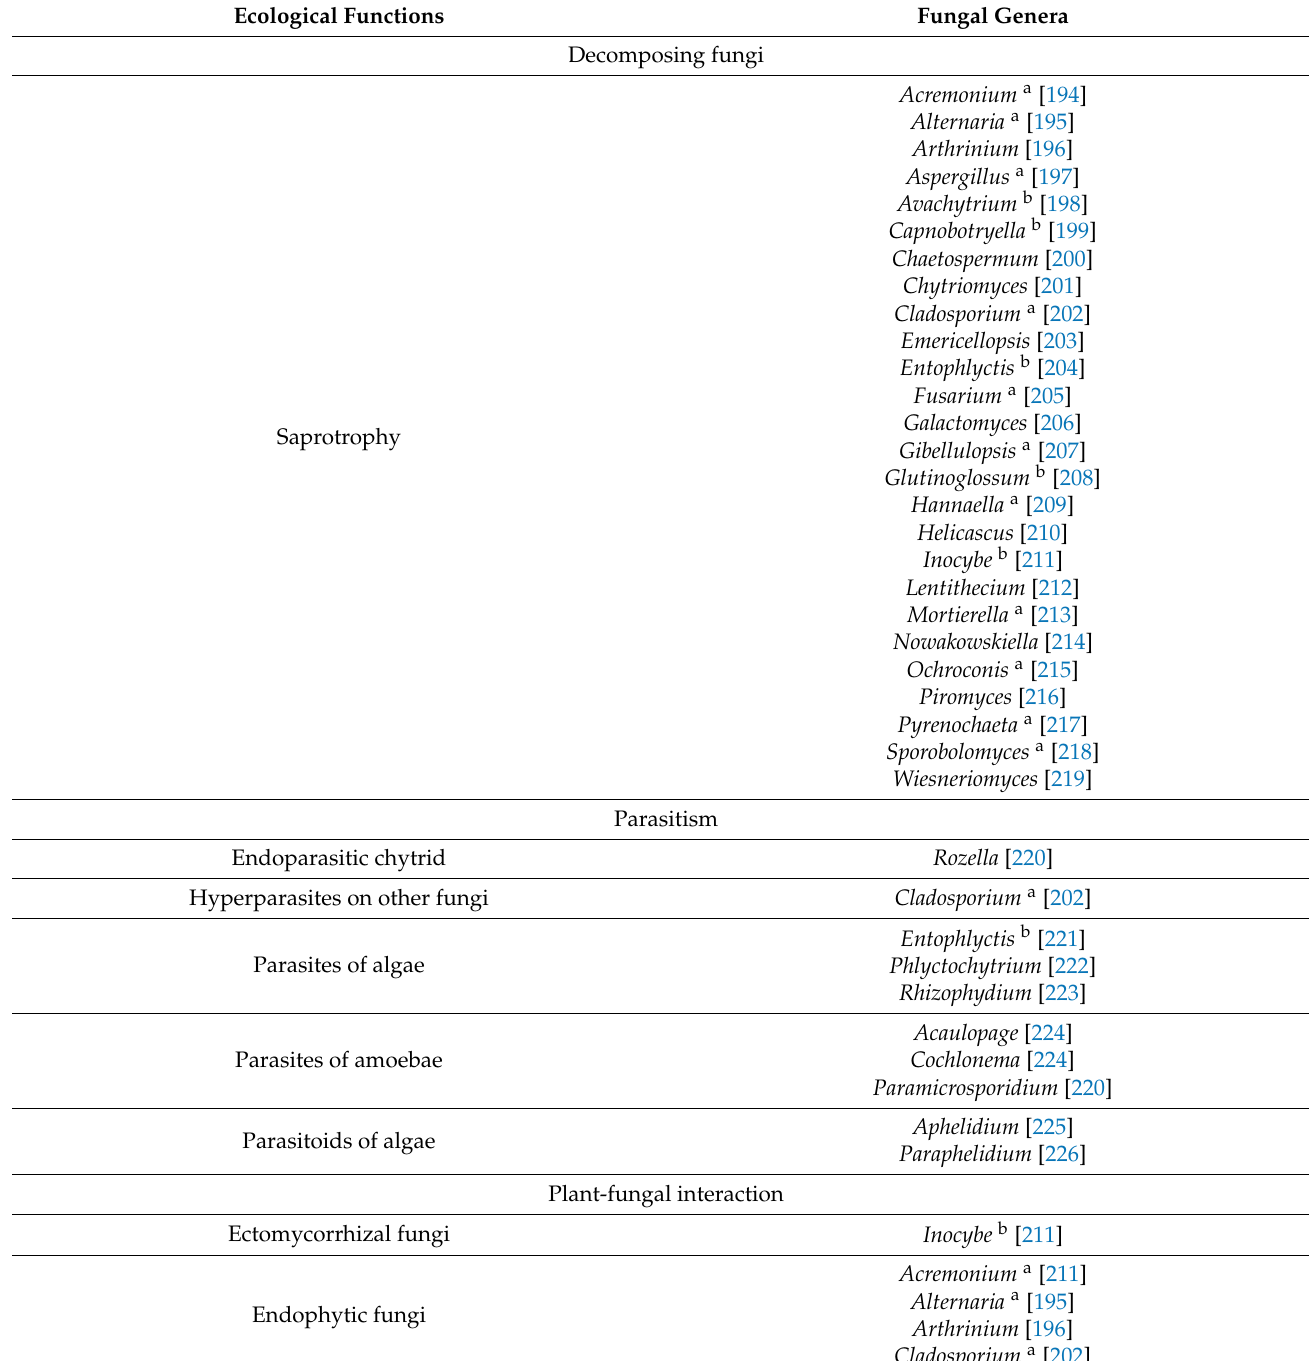
Table 2. Fungal genera commonly present in the Cladophora microbiomes and their putative ecological functions. Ecological